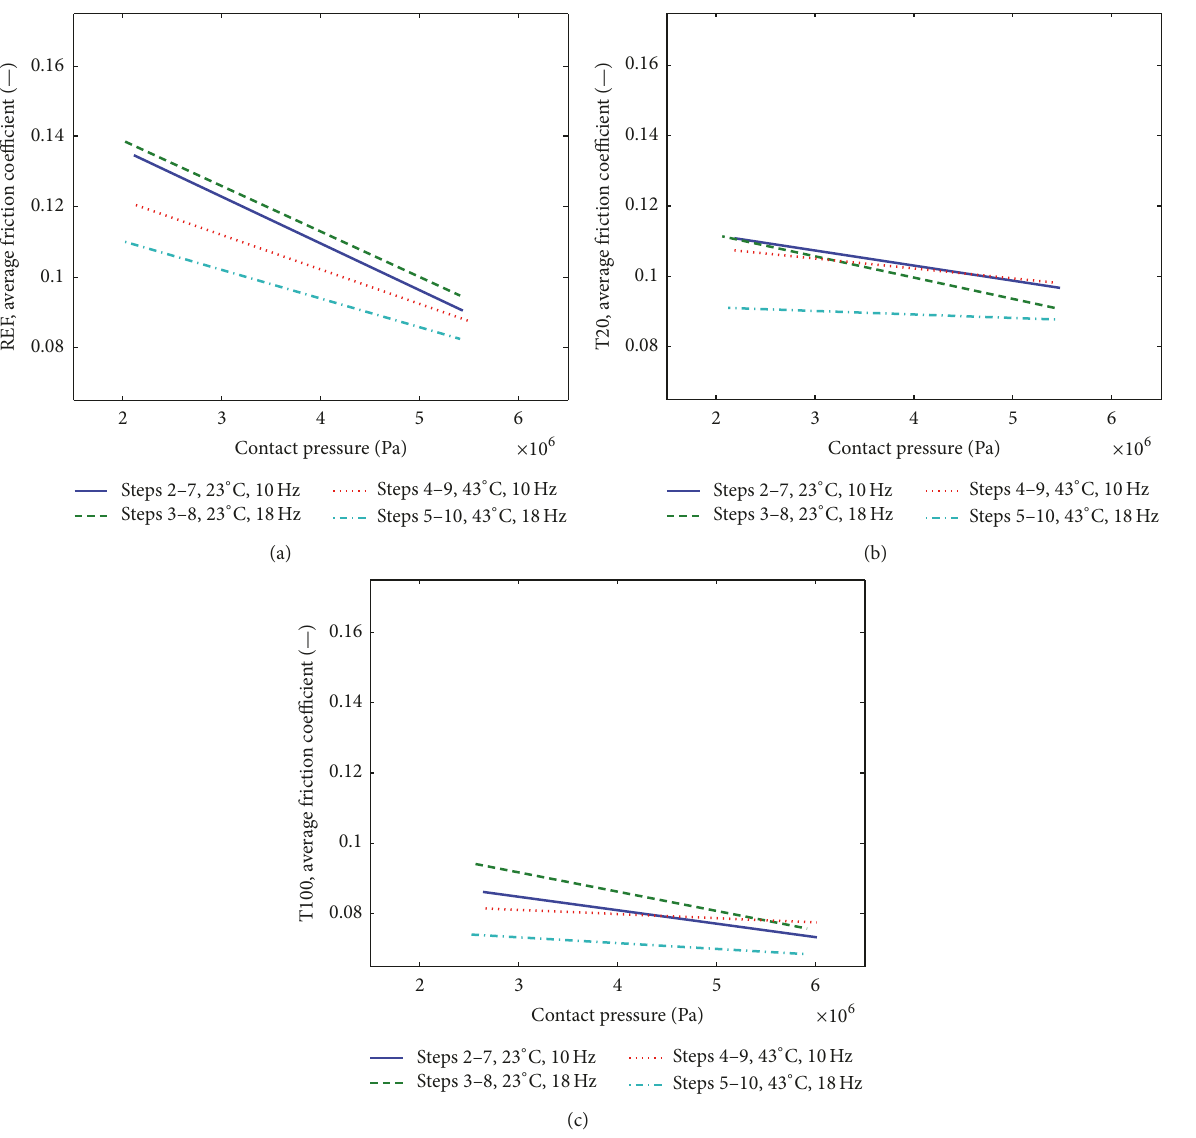
Figure 13: Evaluation of the different levels of DoE input parameters. The effect of contact pressure on the friction coefficient. (a) REF. (b) T20. (c)